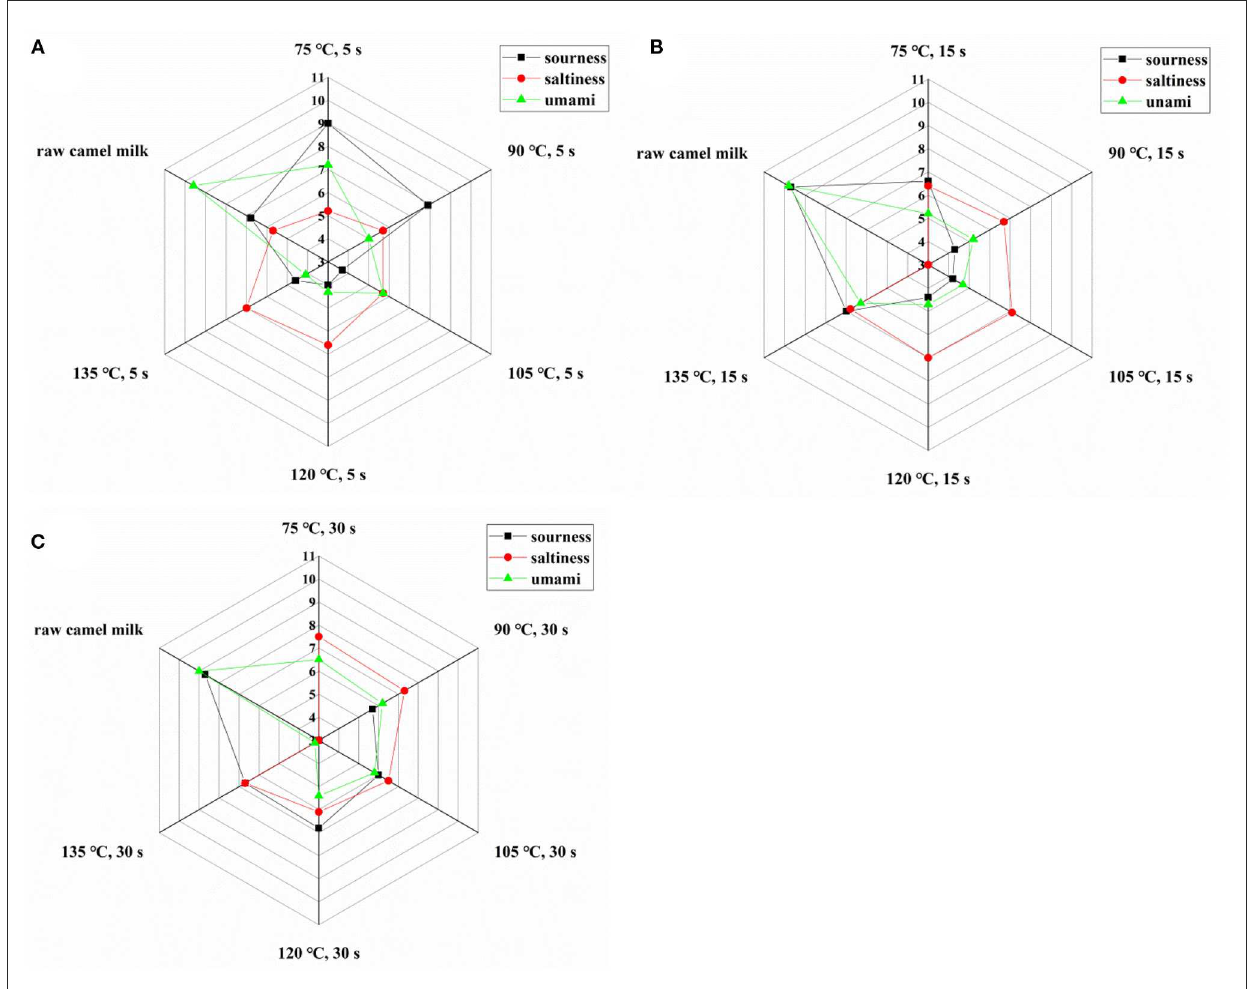
FIGURE3 Taste index of camel milk when heated at different temperatures for 5s (A) , 15s (B) , and 30s (C) .